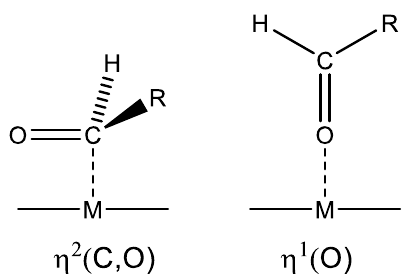
Scheme 1. Types of bonding configurations for aldehydes adsorbed onto metal surfaces (Reproduced from [68] with the permission of John Wiley and Sons, 2012).